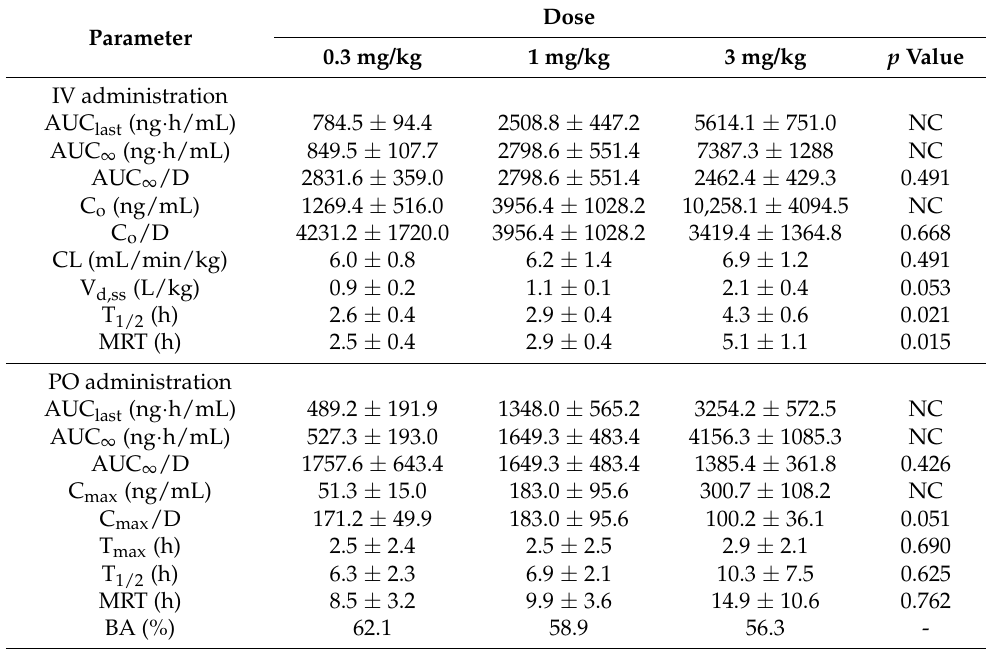
Figure 3. Plasma concentration vs. time profiles of enavogliflozin after ( A ) single intravenous (IV) injection of enavogliflozin at doses of 0.3, 1, and 3 mg/kg and ( B ) single oral administration (PO) of enavogliflozin at doses of 0.3, 1, and 3 mg/kg in SD rats. Data represent mean ± standard deviation (n = 4 per dose for IV, n = 6 per dose for PO). Table 3. Dose-independent pharmacokinetic parameters of enavogliflozin in rats after intravenous and oral administrations of